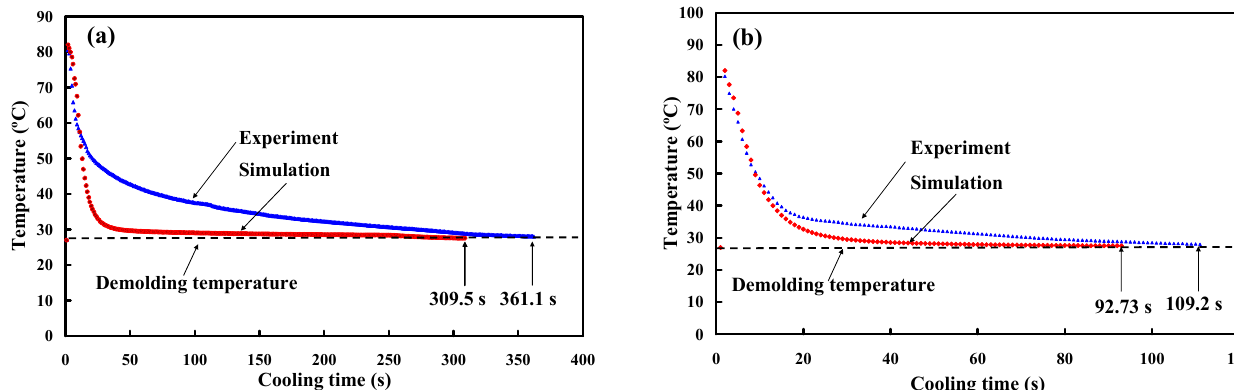
Figure 20. Comparison of simulation results with experimental results ( a ) an injection mold with conventional cooing channels and ( b ) an injection mold with optimum CCCs.